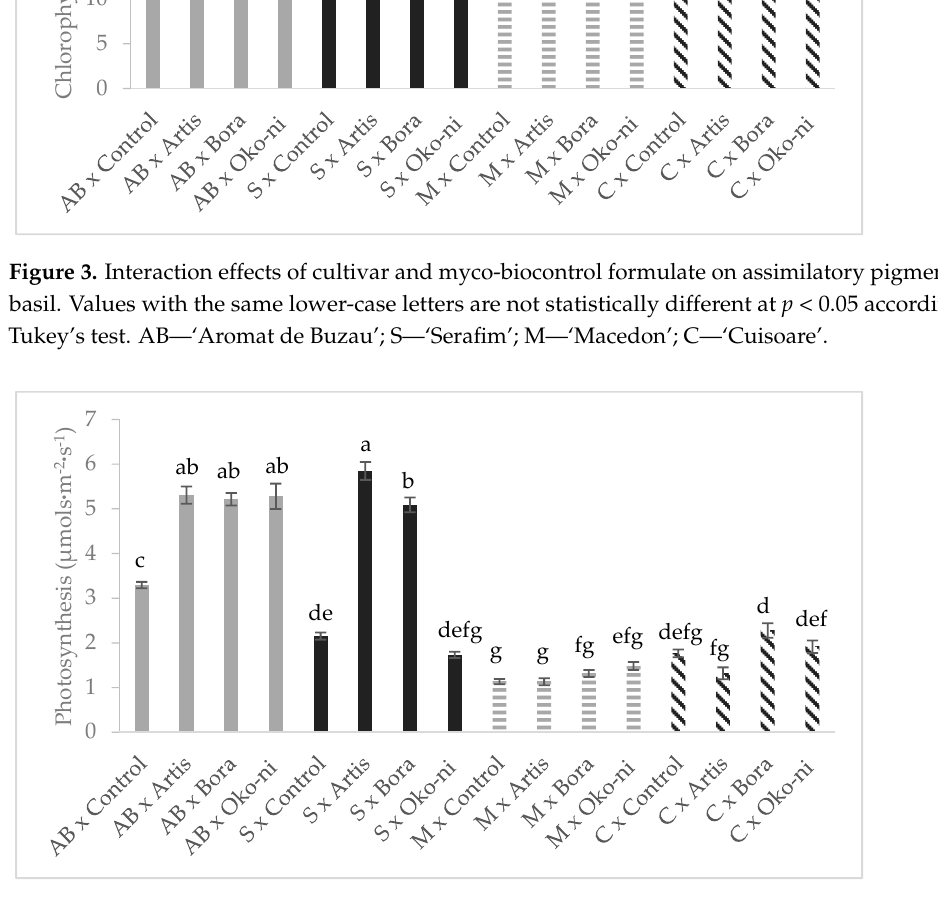
Figure 4. Interaction effects of cultivar and myco-biocontrol formulates on photosynthesis of basil. Values with the same lower-case letters are not statistically different at p < 0.05 according to Tukey’s test. AB—‘Aromat de Buzau’; S—‘Serafim’; M—‘Macedon’;